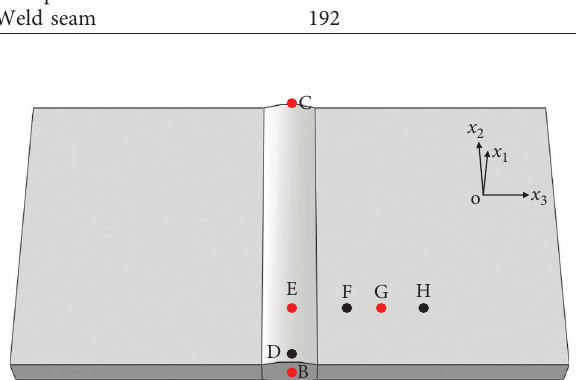
Figure 6: Sensor and load of the welded structure.